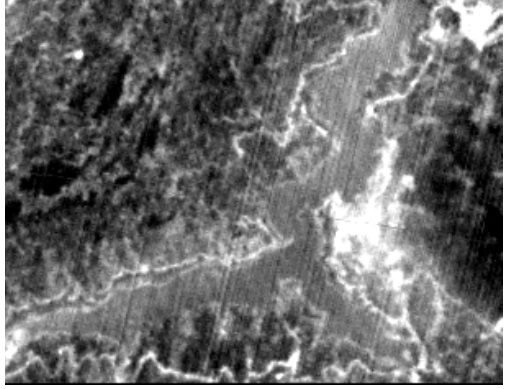
Figure 1. Cbers1 image of Guojiaba Town in Three Gorges.